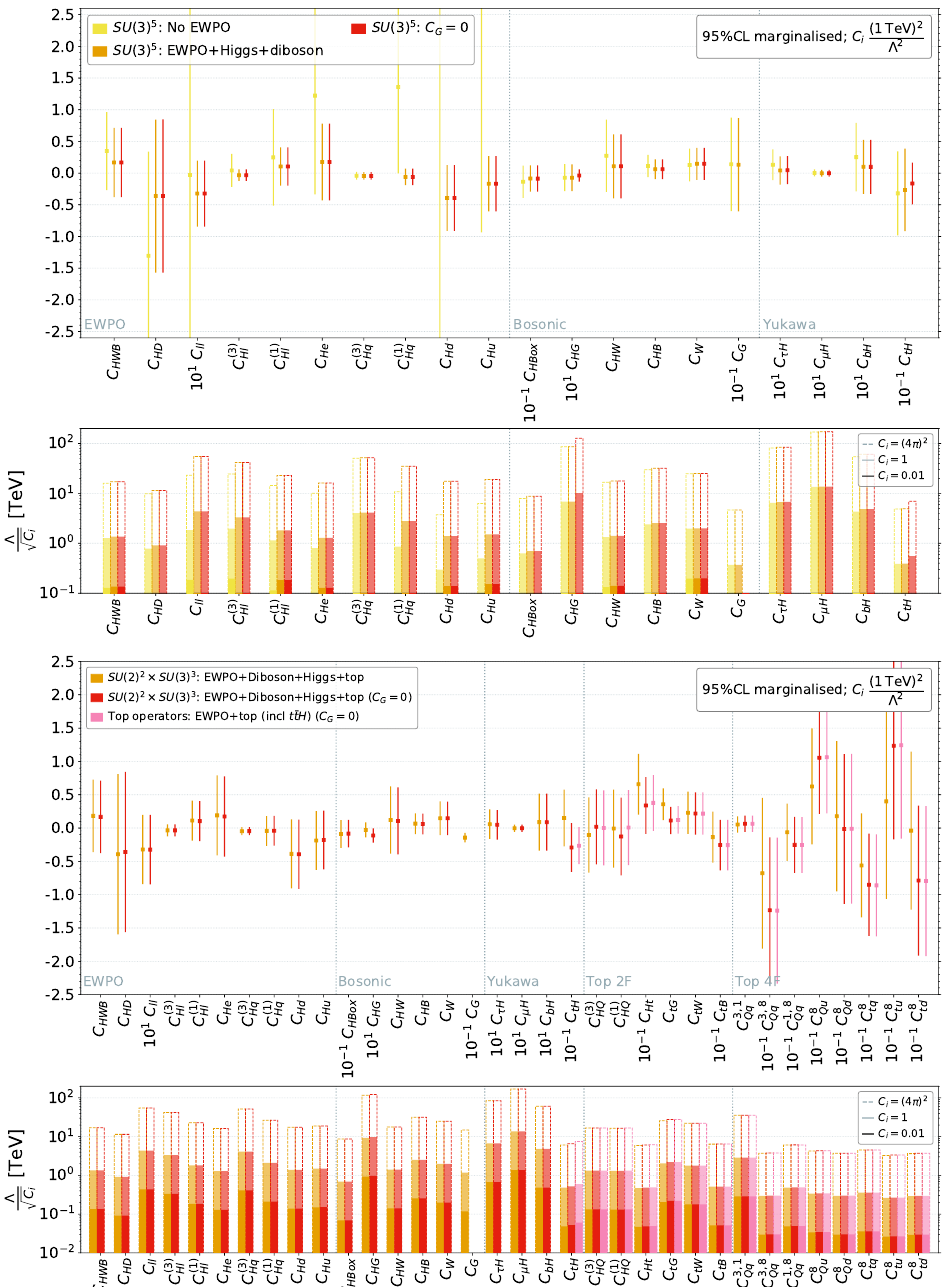
Figure 11 . Comparison of the constraints on the indicated marginalised operator coefficients C i (1 TeV) 2 / Λ 2 (top and third panels) and the corresponding scales Λ for the indicated values of the C at the 95% confidence level (second and bottom panels), found in a combined linear fit to i the Higgs, diboson and electroweak precision observables (top two panels) and including in addition top data (bottom two panels), including C in the fit (orange) and setting C = 0 (red). Also G G displayed in yellow in the top two panels is a fit without LEP (EWPO and WW )